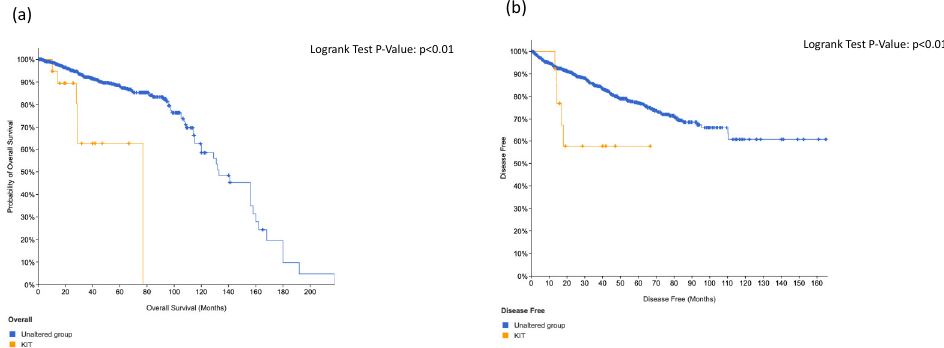
Figure 4. Overall survival ( a ) and disease-free survival ( b ) in ABL1-positive prostate cancer patients.